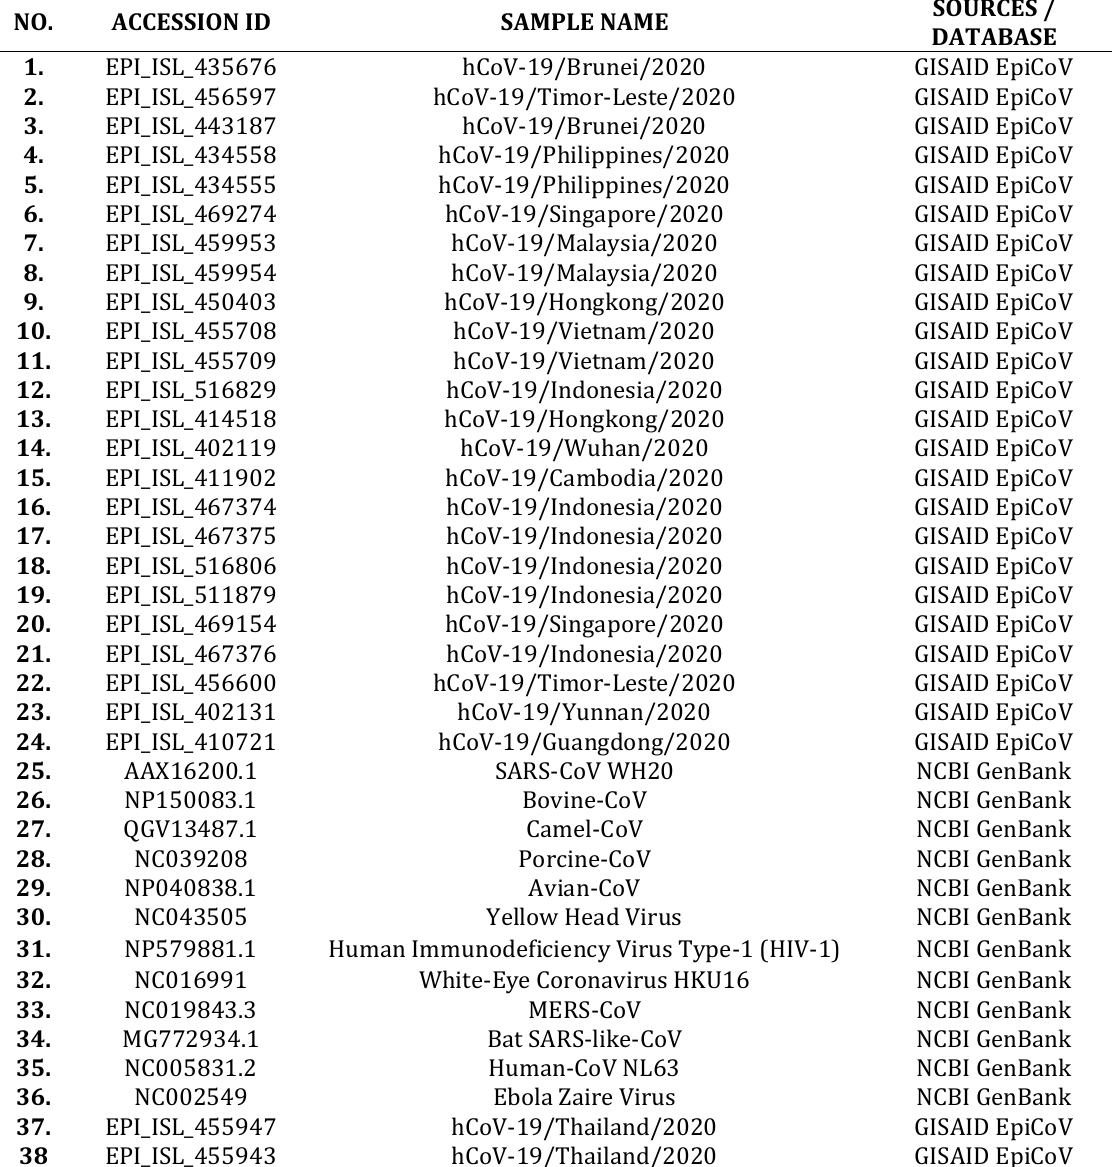
Table I. Samples used for this study. All of the samples were retrieved from GISAID EpiCoV Database and NCBI GenBank. Our study samples were specified to Southeast Asia regions only and some samples from previous coronavirus outbreaks. So, in total there are 38 samples of the coronavirus that will be used in this